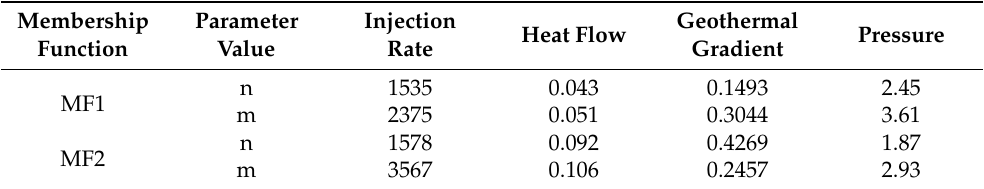
Table 1. Membership function parameters of Nusselt